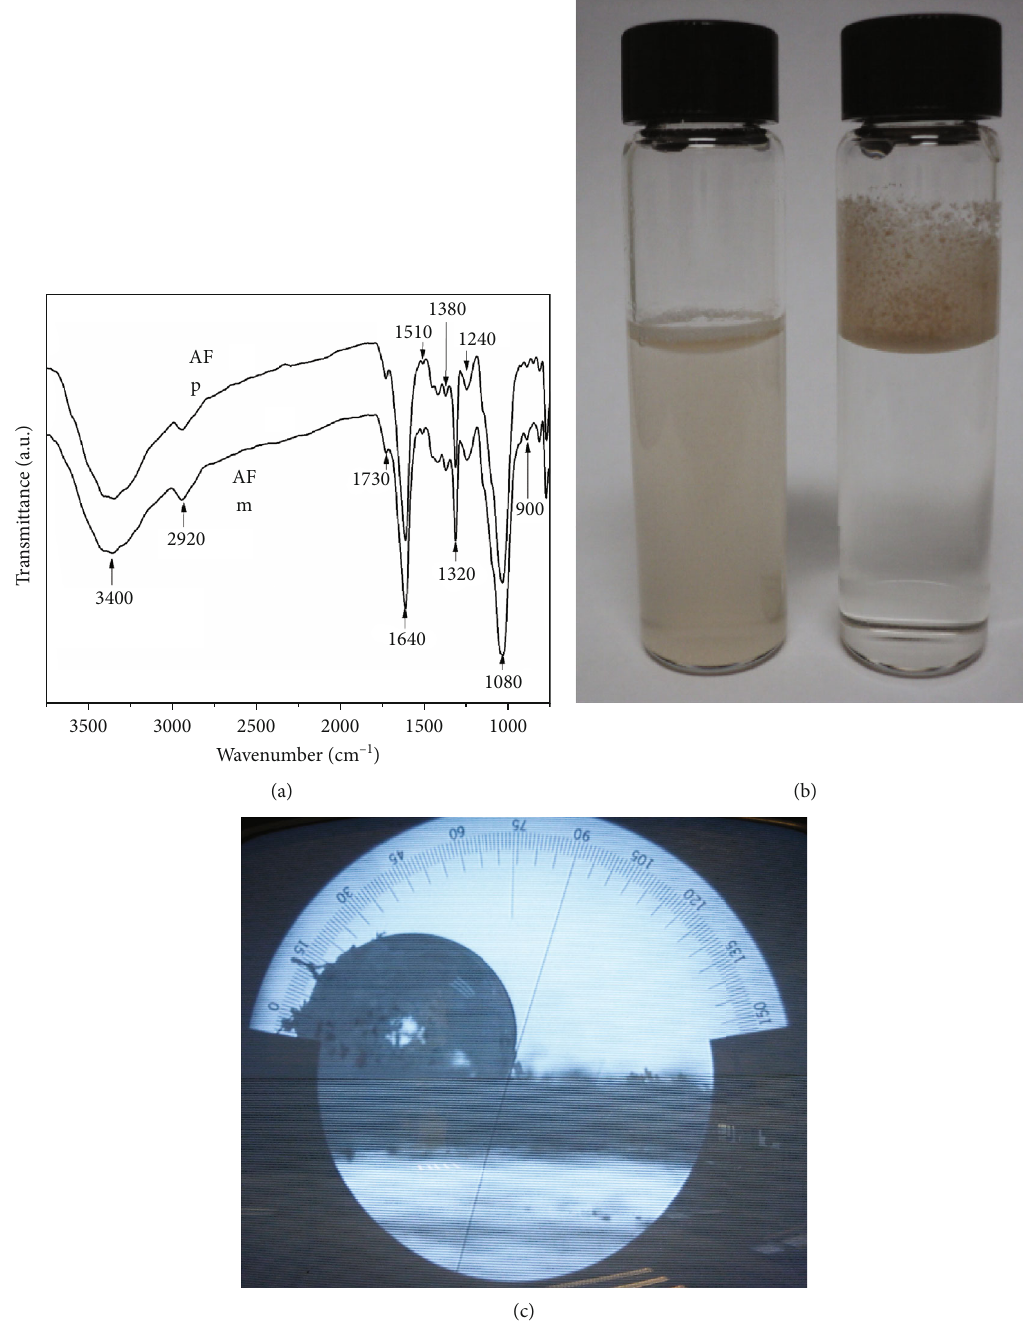
Figure 1: Characterization of the surface of AF measurement of AF m